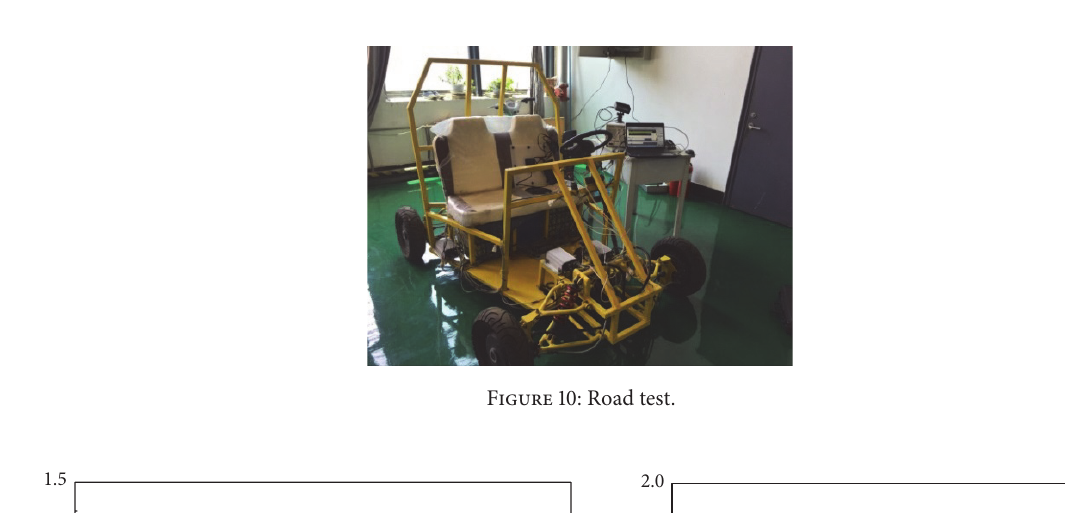
Figure 9: Tire dynamic displacement: (a) time domain and (b) frequency domain.